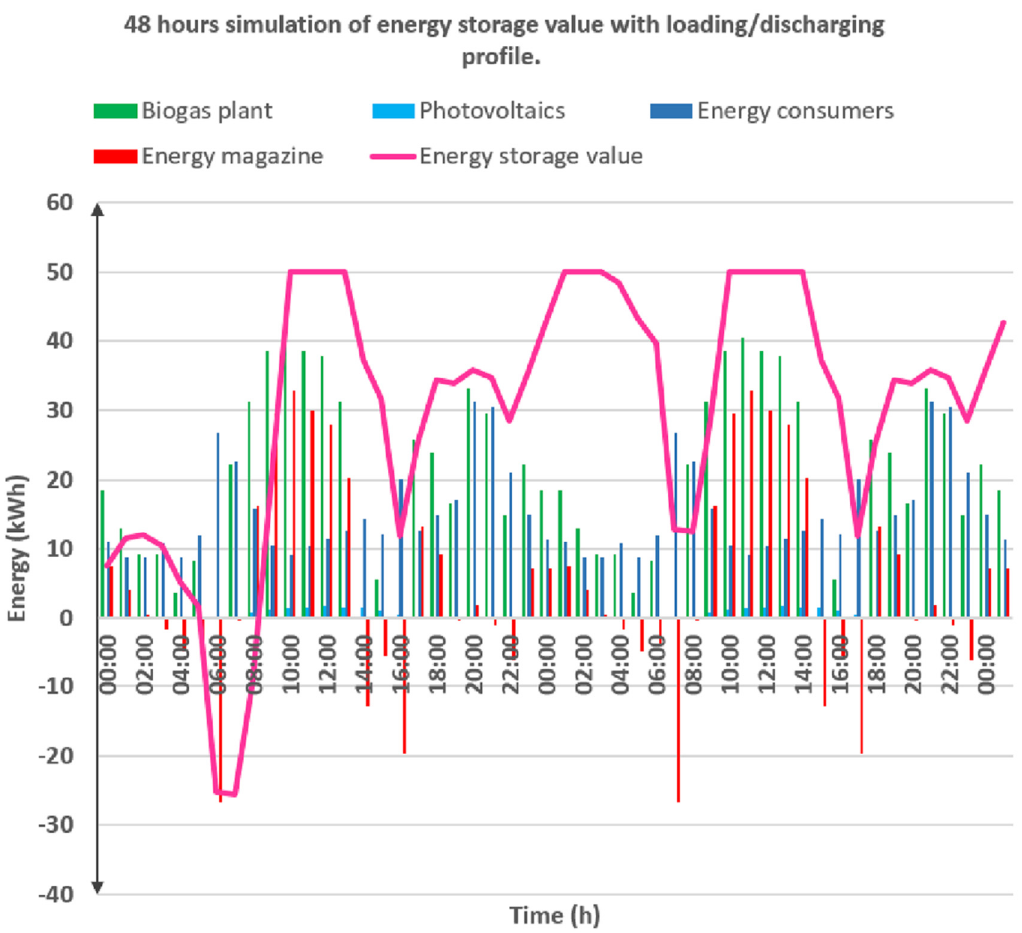
Figure 14. A 48-h simulation of the energy storage unit’s value with a loading/discharging